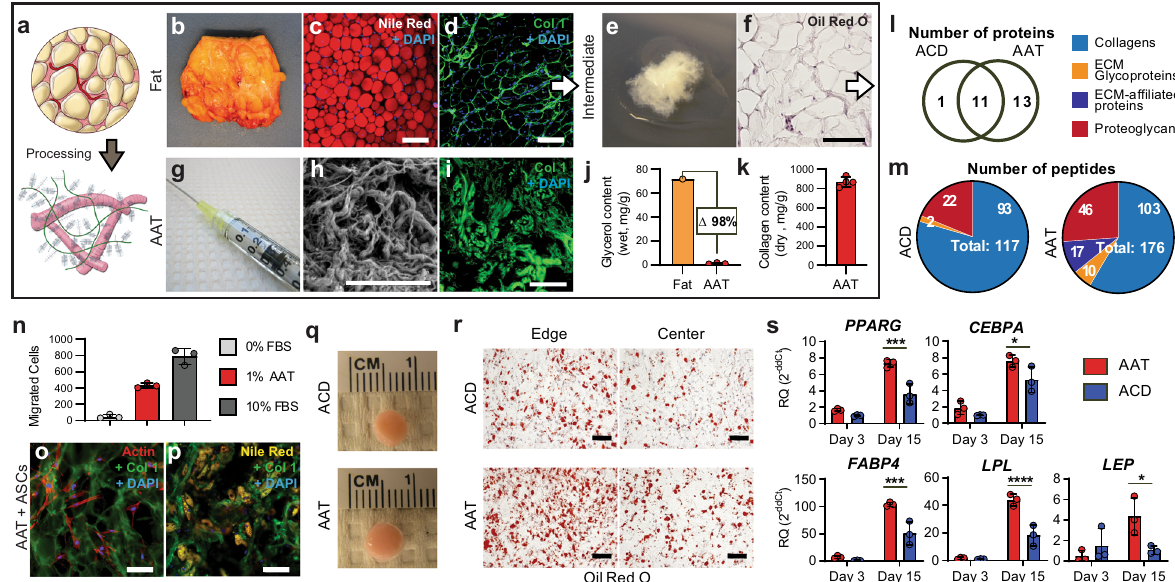
Fig. 1 An adipose-derived biomaterial, Acellular Adipose Tissue (AAT), retains tissue-speci fi c properties favoring in vitro chemo- attraction and adipogenesis. a Macroscopic representation of whole adipose tissue processing to create an injectable, adipose extracellular matrix biomaterial. b Gross images of cadaveric native adipose tissue. c Nile red staining of the central lipid droplets (red) in native adipose tissue. d Fluorescent staining of the collagenous extracellular matrix (Col1 in green, DAPI in blue) surrounding cells in native adipose tissue. e Gross image of the decellularized and delipidated processing intermediate. f Decellularized and delipidated processing intermediate stained for intracellular lipids using Oil Red O (red). g Gross image of the fi nal injectable product. h Scanning electron microscopy of AAT. i Col1 (green) fl uorescent staining of AAT. j Total lipid content of AAT and matched donor adipose demonstrating >98% lipid removal in processing. k Total collagen content determined by a hydroxyproline assay. l AAT-induced migration of adipose-derived stem cells within 6 h in a transwell assay. m AAT reseeded with ASCs stained fl uorescently for Col1 (green) and Actin (red). n Nile Red staining for intracellular lipids (yellow) in ASC-containing AAT supplemented with adipogenic media. o Number of shared and unique proteins between AAT and ACD by LC- MS/MS. p Categorization of peptides identi fi ed in AAT and ACD by LC-MS/MS. q 3D constructs of ASCs cultured in ACD and AAT. r Oil Red O staining (red) from both the edge and center of constructs. s Differential gene expression for adipogenic markers within 3D constructs normalized to ACD on Day 3. Signi fi cance ( p -values): * < 0.05, ** < 0.01, *** < 0.001, **** < 0.0001. Error bars represent ±1 standard deviation. Scale bars represent 100